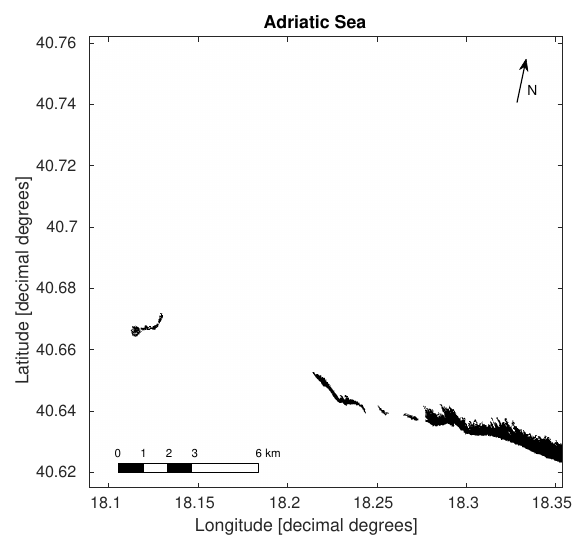
Figure 8. Segmented binary image. See Figure 4 for the location.